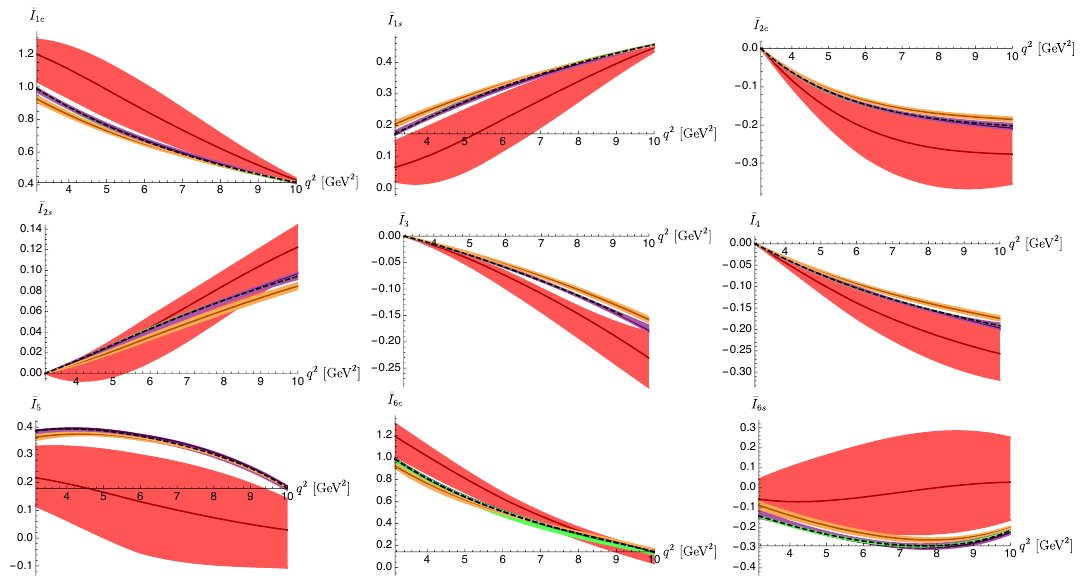
Figure 11 . (cid:22) I i , de(cid:12)ned in eq. (5.1), for di(cid:11)erent scenarios. Same colour legend as in (cid:12)gure 10. In (cid:12)gure 11 we plot the B ! D (cid:3) (cid:28) (cid:22) (cid:23) angular coe(cid:14)cients, as functions of q 2 , normalized by the decay